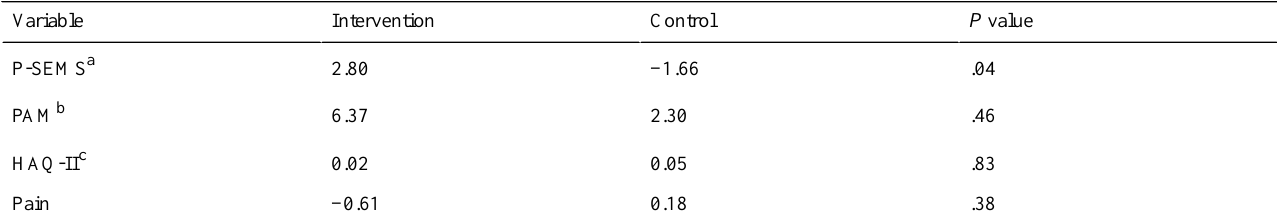
Table 1. Quantitative outcome variables.